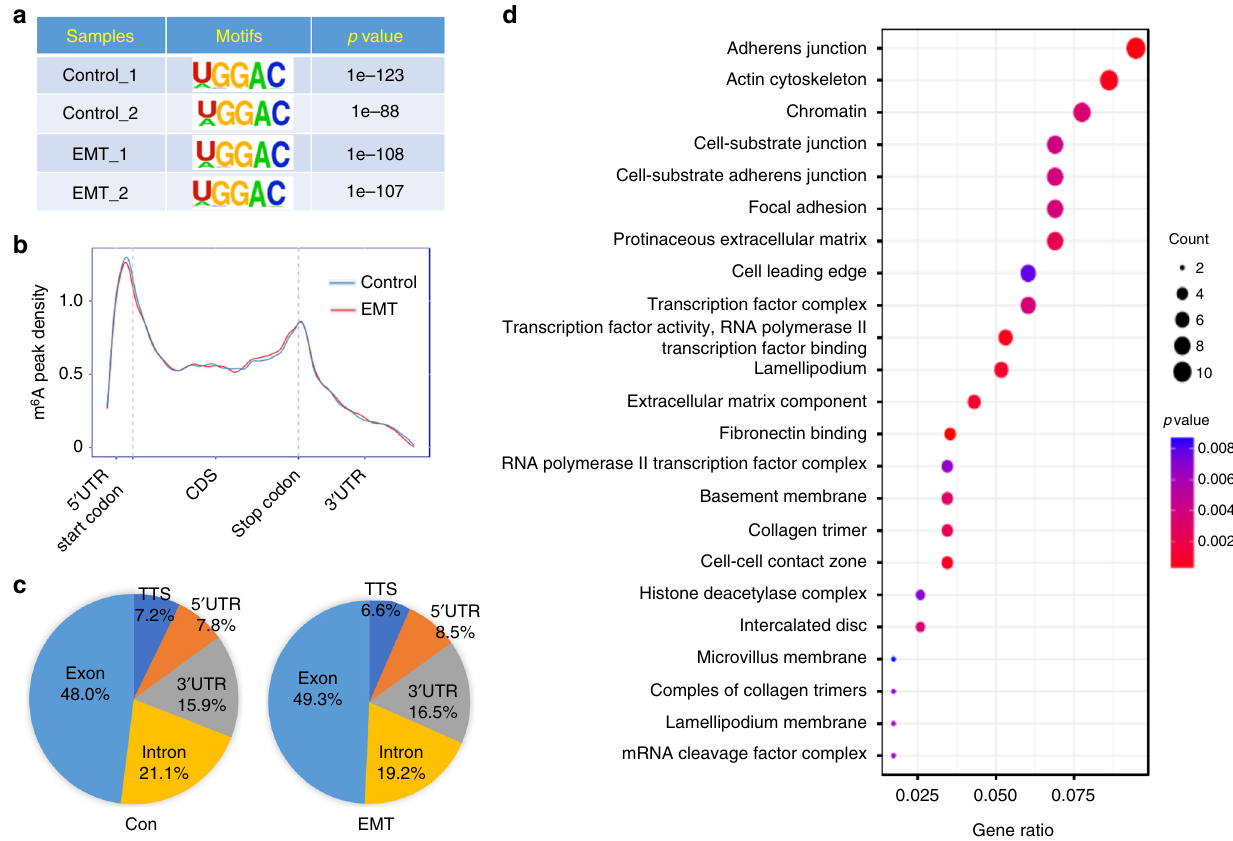
Fig. 2 Variations of m 6 A-regulated genes in cells undergoing EMT. a Predominant consensus motif GGAC was detected in both the control and EMT cells in m 6 A-seq. b Density distribution of m 6 A peaks across mRNA transcripts. Regions of the 5 ′ untranslated region (5 ′ UTR), coding region (CDS), and 3 ′ untranslated region (3 ′ UTR) were split into 100 segments, then percentages of m 6 A peaks that fall within each segment were determined. c Proportion of m 6 A peak distribution in the 5 ′ UTR, start codon, CDS, stop codon or 3 ′ UTR region across the entire set of mRNA transcripts. d A cluster pro fi ler identi fi ed the enriched gene ontology processes of 128 genes, which showed 1.5-fold m 6 A expression upregulation in EMT cells compared with control